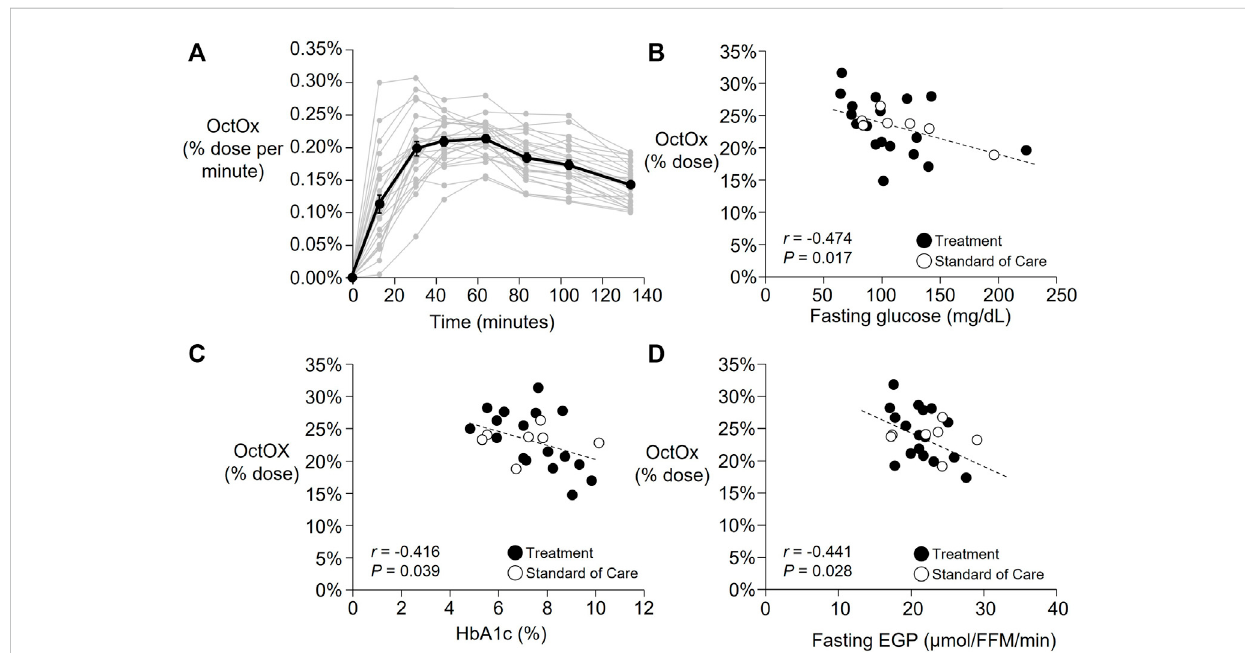
FIGURE 2 Part 1: Baseline time courses of the percentage of the octanoate dose oxidized (OctOx) per minute and correlations with baseline markers of glucose metabolism. (A) Percentage of the octanoate dose oxidized per minute are shown for all baseline tests (n = 25). Mean data shown in black line with individual subject data are shown in grey. ( B – D) : Pearson ’ s correlations between baseline percentage oxidation of the oral octanoate dose over 135 min (n = 25) and (B) fasting plasma glucose concentration, (C) HbA1c, and (D) fasting endogenous glucose production (EGP) relative to fat free mass(FFM).While allsubjects wereanalyzedtogetheratbaseline,thesubjectsthat wererandomized tostandardofcareareshown inun fi lled circles(n = 7) and those in treatment in fi lled circles (n = 18). Three subjects initially randomized to the treatment group did not complete follow-up